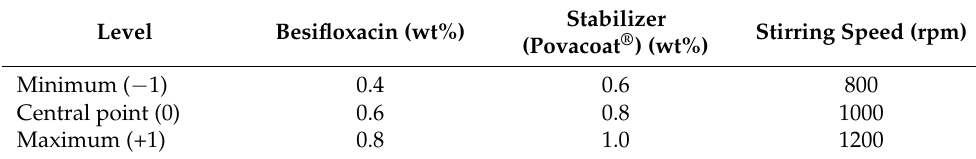
Table 1. Independent variables and levels selected for Box–Behnken design. Level Besifloxacin (wt%)